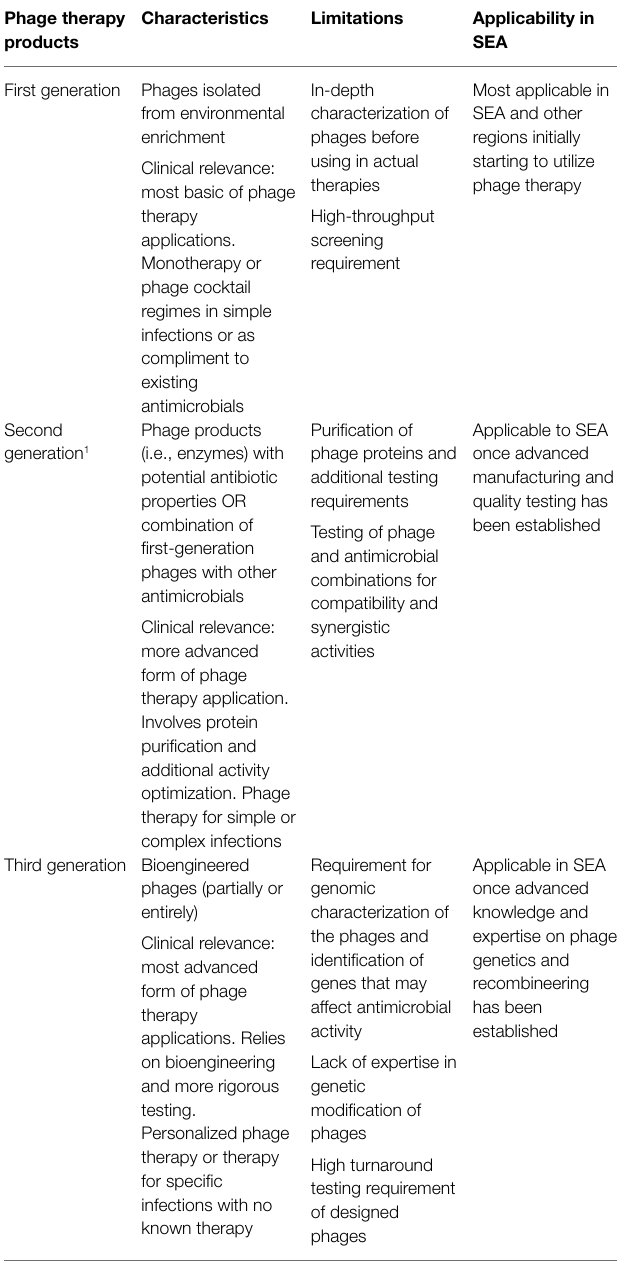
TABLE 3 | Phage therapy products and its applicability in